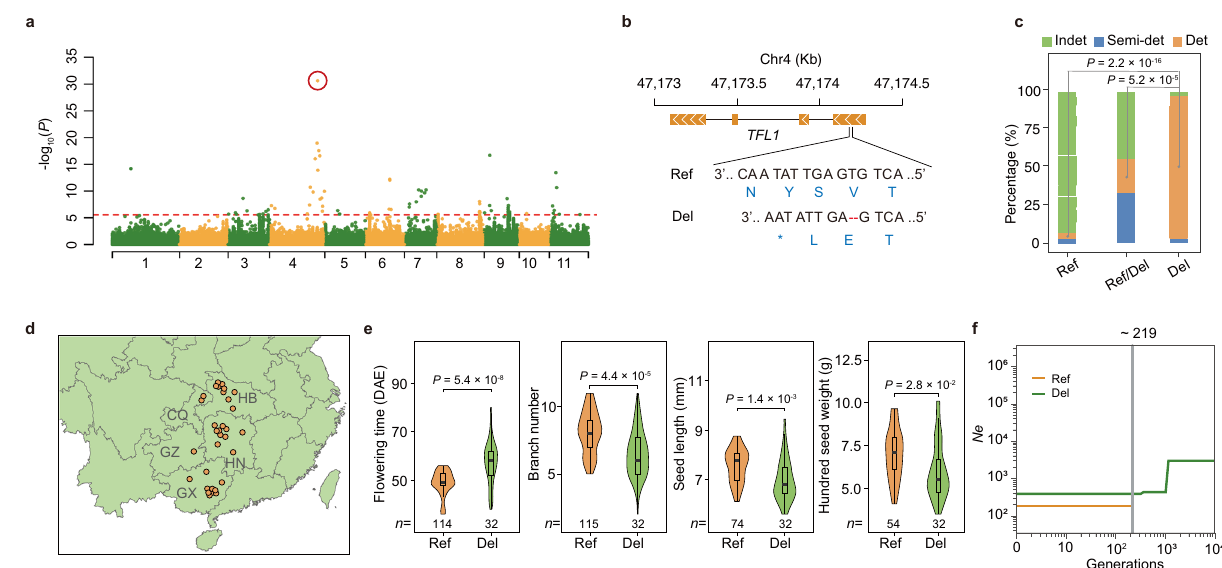
Fig. 5 | The molecular basis and selection history of stem determinacy in cul- tivated rice bean. a InDel-based GWAS result from the analysis of data for stem determinacy measured at the Nanning site in 2020. The peak InDel is indicated by the red circle. The red horizontal dashed line indicated the Bonferroni-corrected signi fi cancethresholdsofGWAS( α =1). b A2-bpcausativedeletion(thepeakInDel) introduced a premature termination codon in the fi rst exon of the TFL1 gene. Ref reference,Deldeletion. c Thefrequencydistributionsofthreetypesofstemgrowth habit (indeterminate (Indet), semi-determinate (Semi-det), and determinate (Det)) among three groups comprising landraces carrying the homologous reference alleles (designated as Ref), heterozygous (Ref/Del) or homologous mutation (2-bp deletion) alleles (Del), respectively. Two-sided Fisher ’ s exact tests were used to assessthesigni fi canceofthe differencesintheproportionof thedeterminate type of stem growth habit between landraces carrying Ref and Del alleles and between landraces carrying Ref/Del and Del alleles. d The geographical distributions of the